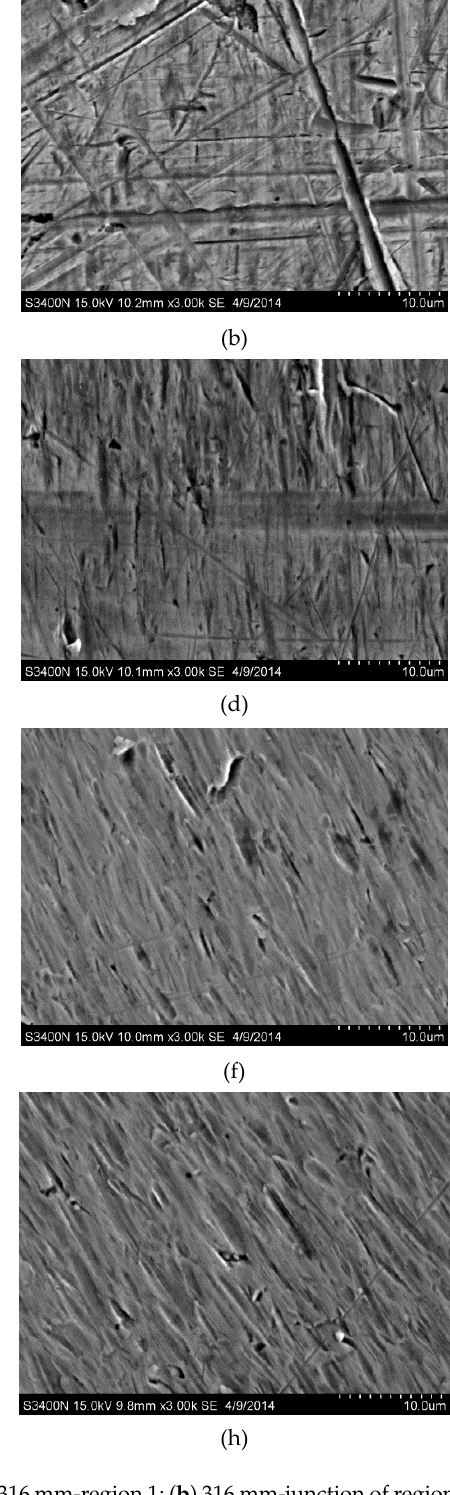
Figure 20. Morphology of the stainless steel sample: ( a ) 316 mm-region 1; ( b ) 316 mm-junction of region 1 and region 2; ( c ) 316 mm-region 2; ( d ) 316 mm- junction of region 2 and region 3; ( e ) 316 mm-region 3; ( f ) 225 mm-region 1; ( g ) 225 mm- junction of region 1 and region 2; ( h ) 225 mm-region 2.